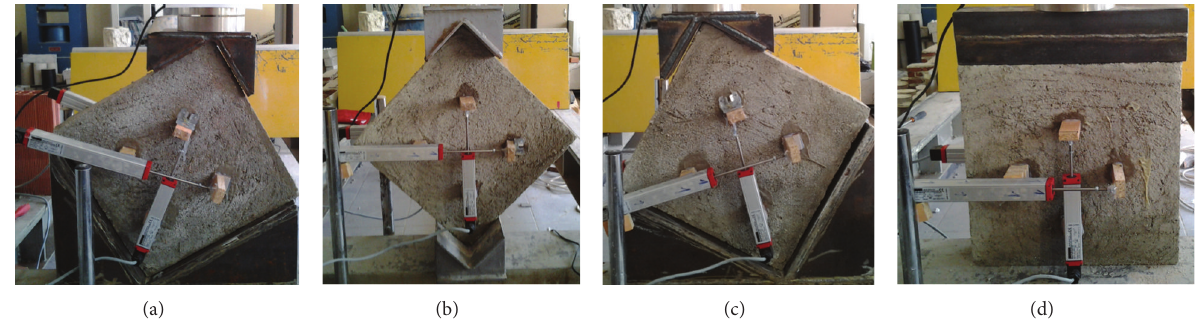
Figure 8: Experiments at 30 ∘ , 45 ∘ , 60 ∘ , and 90 ∘ angles.